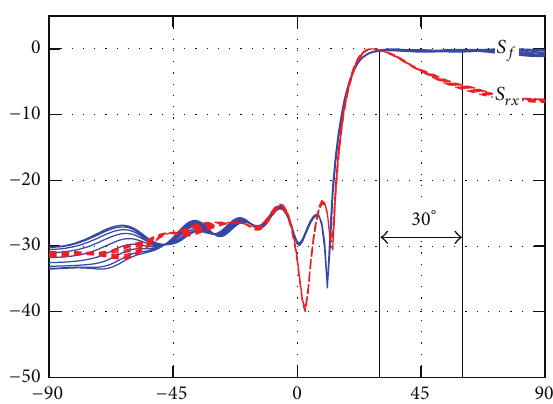
Figure 17: Azimuth crosscuts of the 𝑆 𝑓 and 𝑆 𝑟𝑥 patterns steered to (50 ∘ , 45 ∘ ) , covering the range 40 ∘ ≤ 𝜙 ≤ 60 ∘ in the azimuth plane ( 20 ∘ in Figure 18).